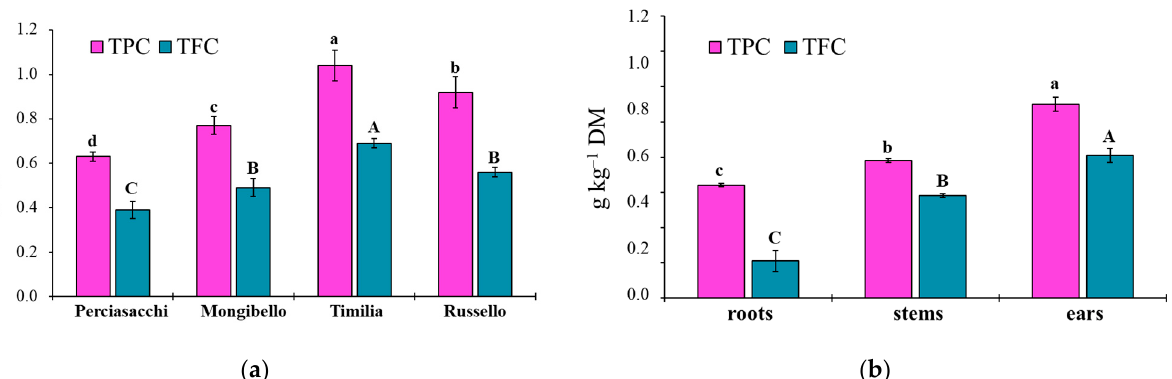
Figure 5. Total polyphenol (TPC) and total flavonoid (TFC) content in roots, stem and ears of durum wheat extracts in relation to the genotype ( a ) and plant part ( b ). Different letters (a–d) indicate significant differences for the TPC ( p ≤ 0.05). Different letters (A–C) indicate significant differences for the TFC ( p ≤ 0.05). Bars indicate ± standard error. DM: dry matter.